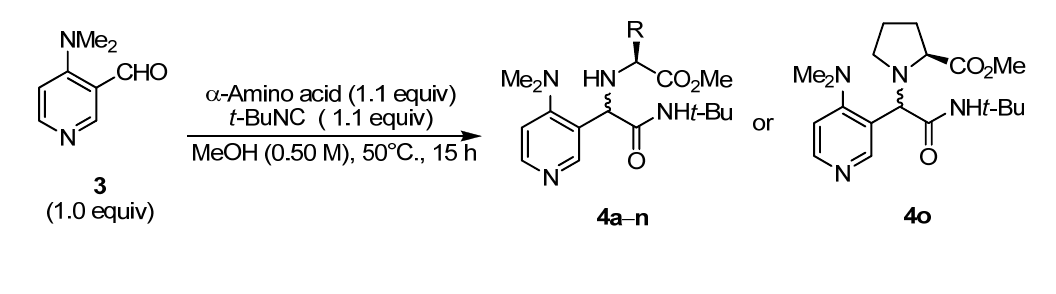
Table 5. Ugi reaction of 3 with various  -amino